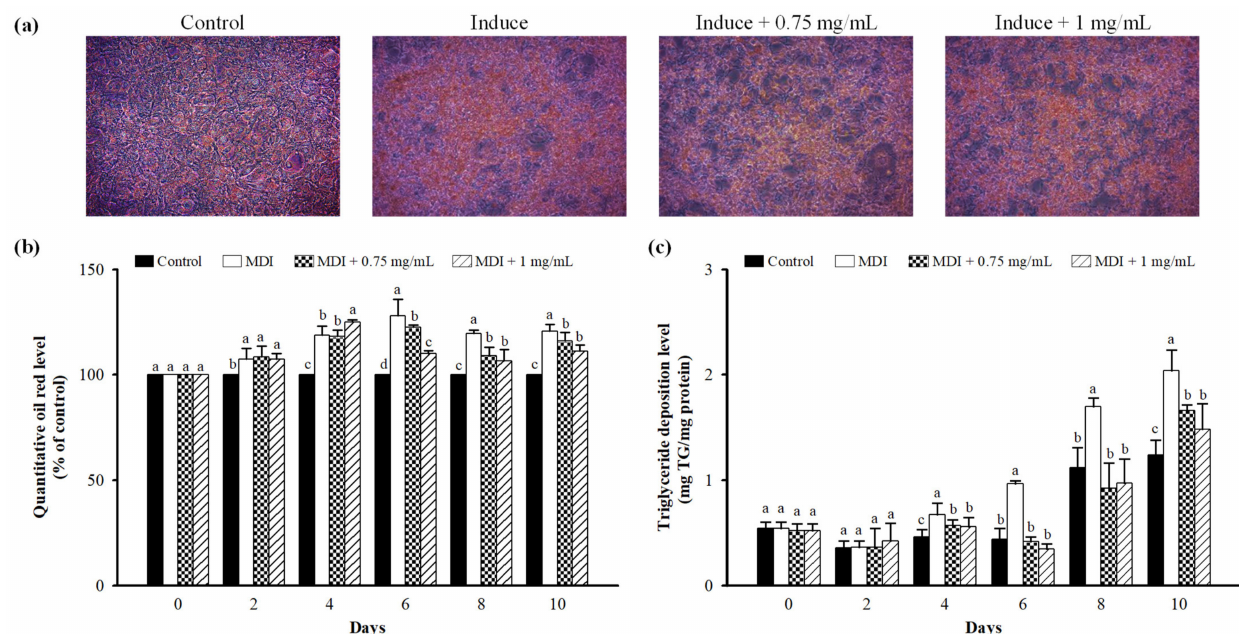
Figure 4. Effect of LFP on lipid accumulation in 3T3-L1 adipocytes. 3T3-L1 adipocytes were incubated in MDI medium containing 0.75, 1 mg/mL LFP for 10 days. Cells were collecting every two days. ( a ) Cell lipid accumulation levels were measured by staining with Oil Red O and observed under the microscope ( × 200)—picture only shows the final day. ( b ) 3T3-L1 adipocytes relative amount of control lipid accumulation (%). ( c ) Calculation followed by TG concentration (mg TG/mg protein) = mg TG/mg protein. Control: undifferentiated cells. The significance of difference in lipid accumulation evaluated by Duncan’s test. Data are the means ± SD ( n = 4). Different letters (a–c) indicate significant differences among the different concentrations of the LFP group ( p < 0.05).